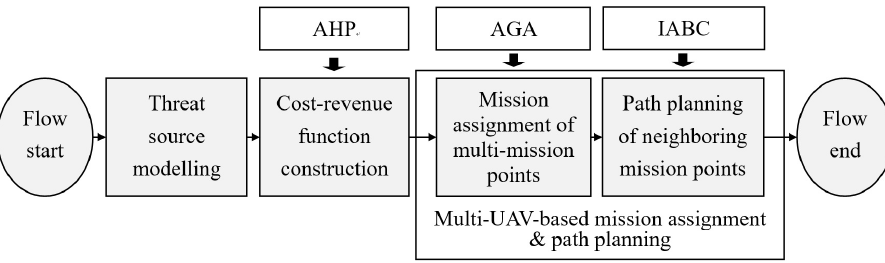
Figure 2. Proposed computational flow chart.